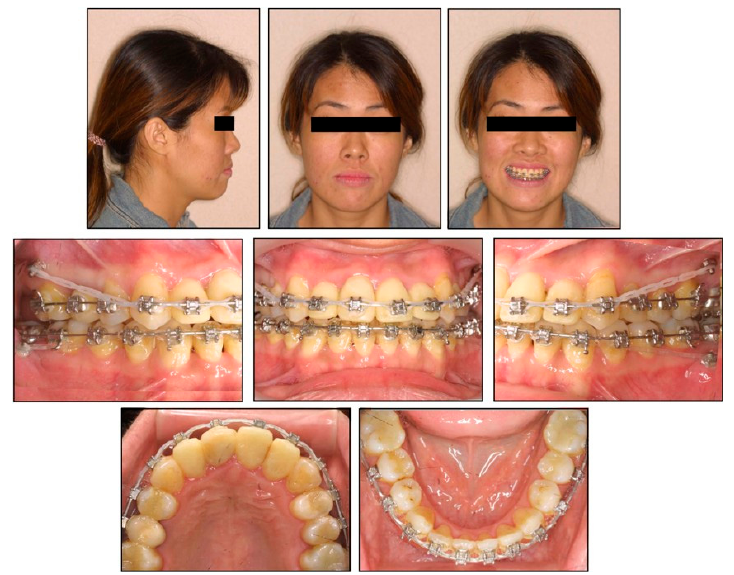
Figure 12. Case 2, Two upper posterior miniscrews were installed in the eighth month for the protrusion after the correction of anterior crossbite.